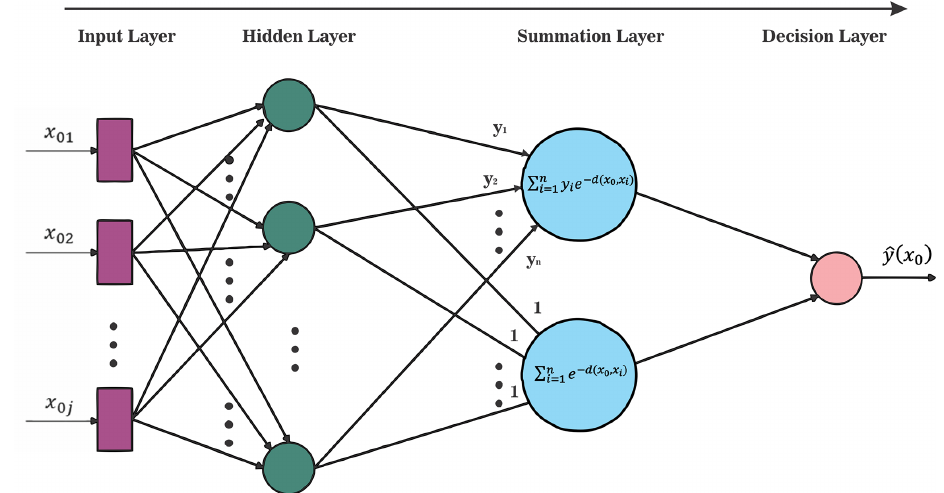
Figure 2. Flowchart explaining the steps involved in estimating the anthropogenic CO 2 emissions using OCO-2 XCO 2 retrievals (Yang et al.,